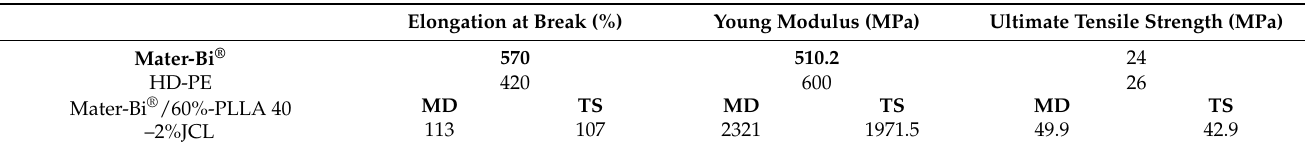
Table 6. Main tensile properties of the corresponding blend in the machine direction (MD) and transverse direction (TD) of the blown film, and comparison with film from HDPE and neat Mater-Bi ® . Elongation at Break